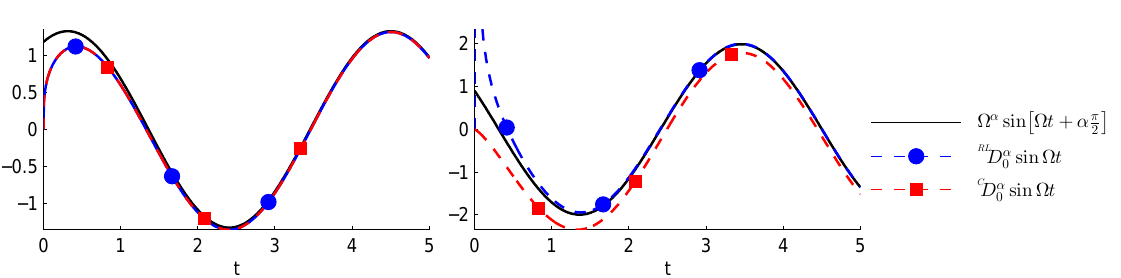
(cid:0) Ω (cid:1) t + α π for Ω = 1.5, α = 0.7 2